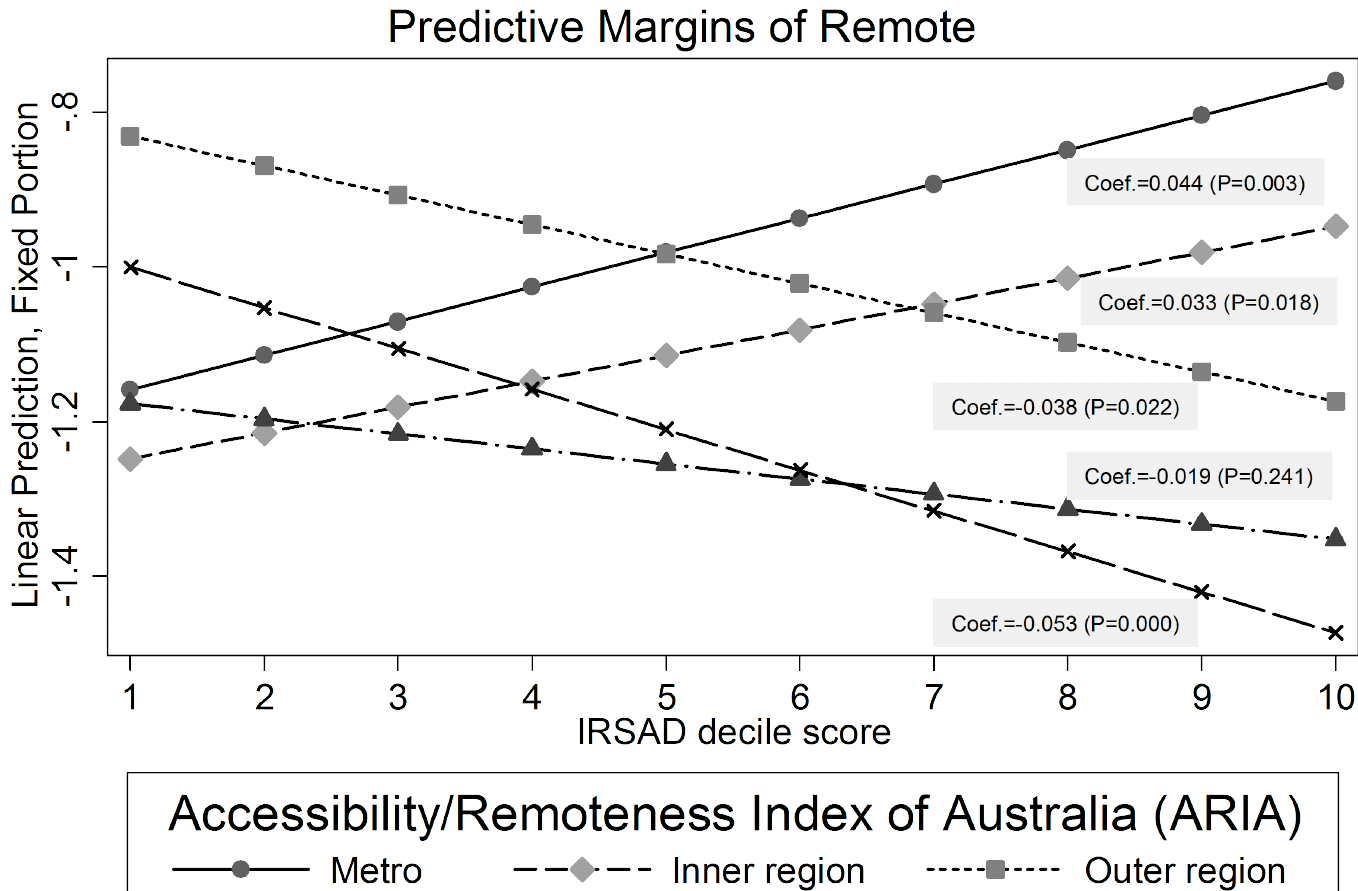
Figure 2: Predicted margins (log-odds) of mental health contact by geographic remoteness and IRSAD